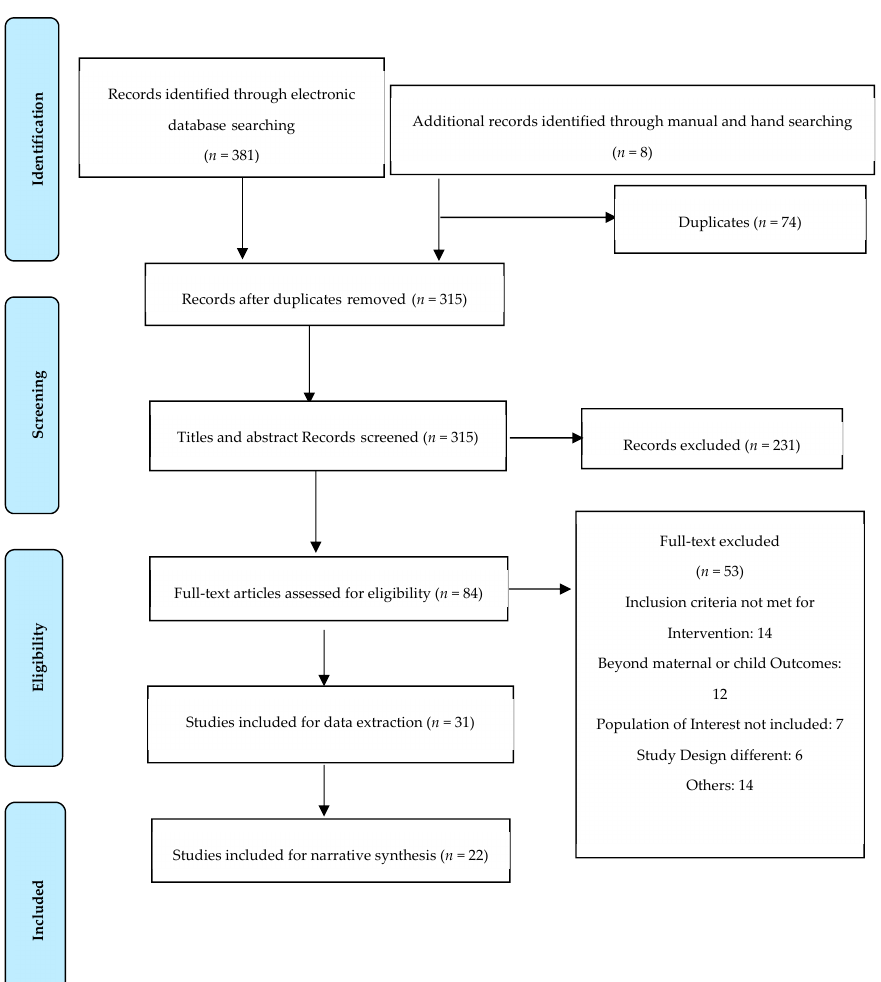
Figure 1. A PRISMA flow chart illustrating search and screening results.